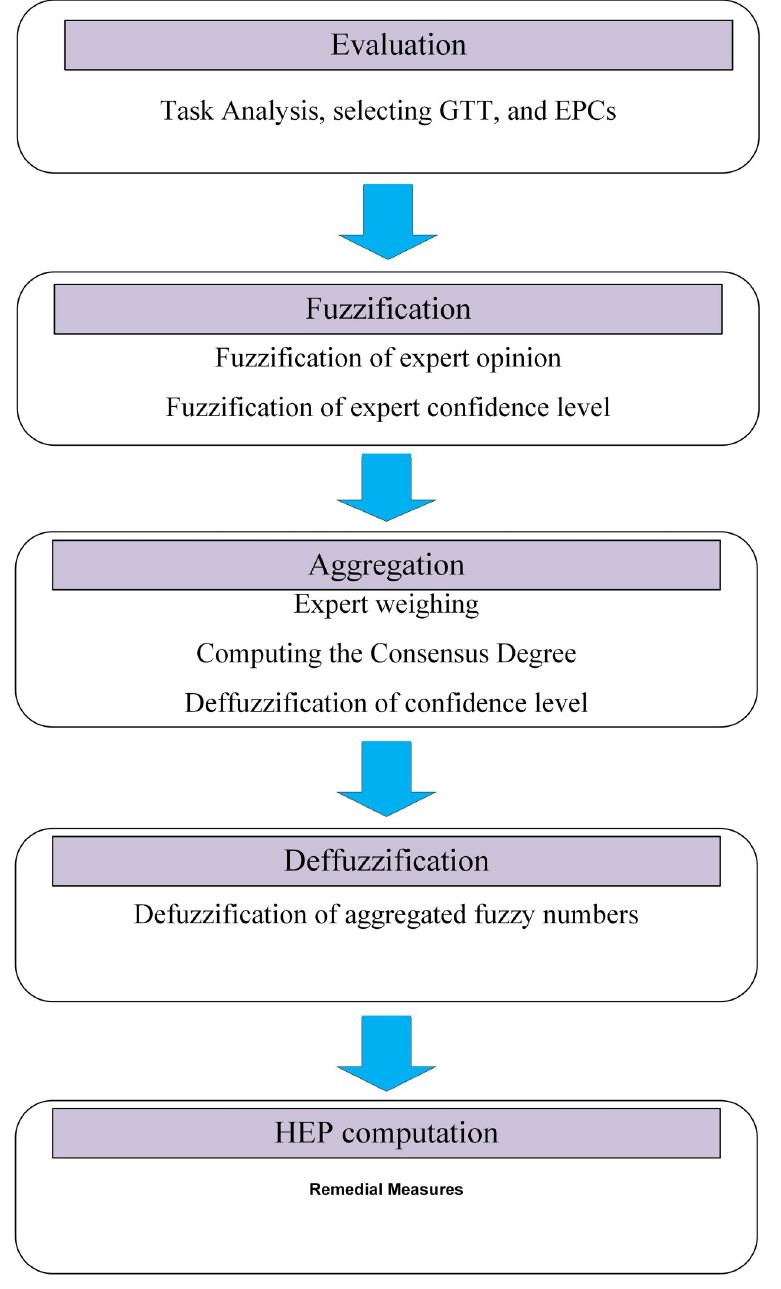
Fig 4. Algorithm of the proposed